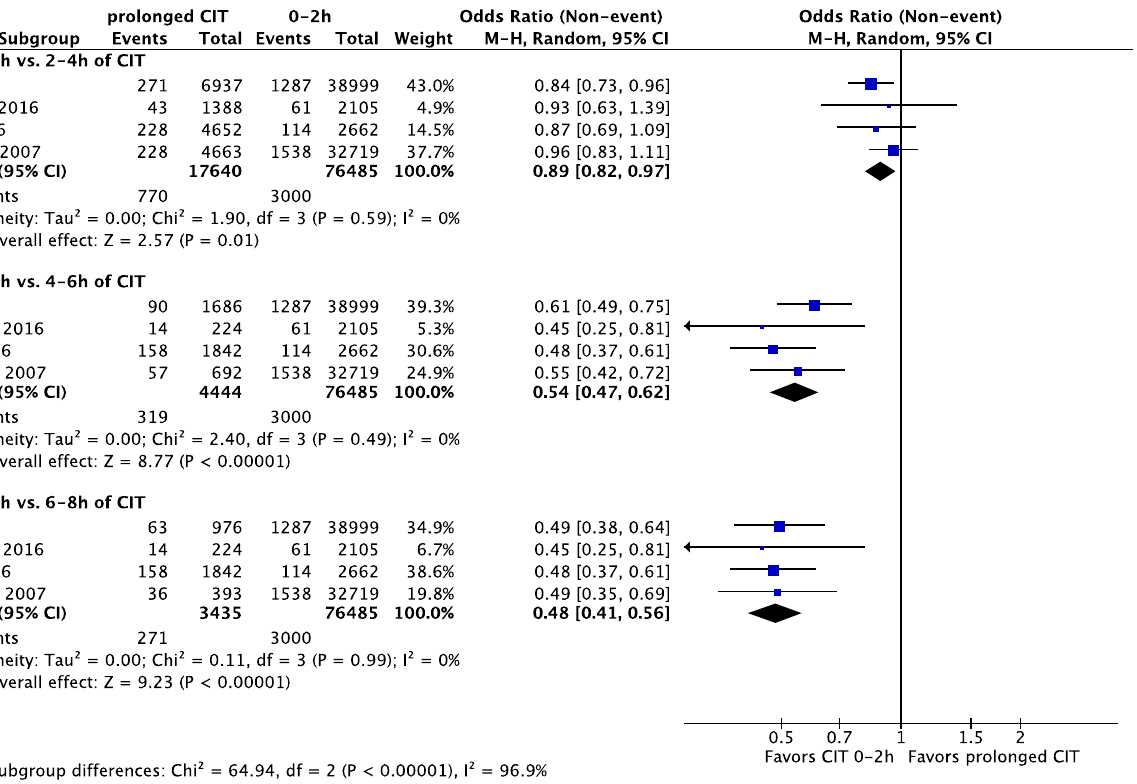
Figure 3. The incidence of DGF in 0–2 h (reference) of CIT versus 2–4, 4–6 and 6–8 h of CIT. CIT: cold ischaemia time; DGF: delayed graft function.